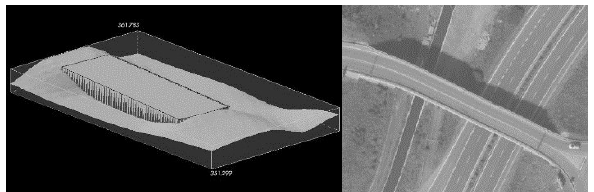
Figure 4. DMR 4G replenished by a bridge from ZABAGED® - altimetry (left) and aerial photograph orthorectified by this model (right)